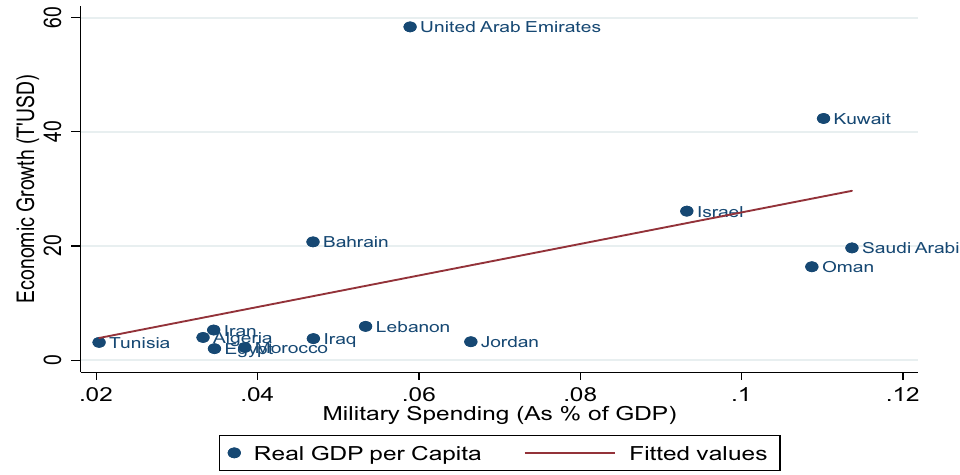
Fig. 8 Real GDP per capita and military burden in selected MENA countries